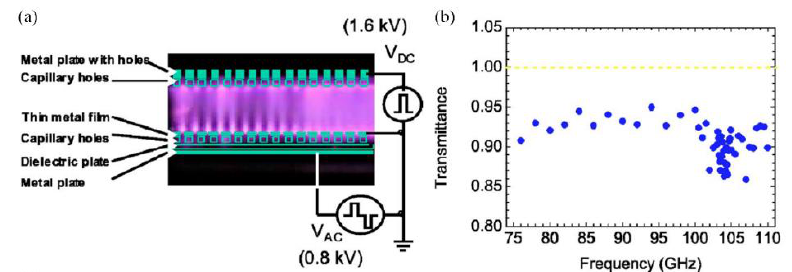
Figure 7. Microplasma column array and its filtering characteristic diagram. ( a ) Schematic diagram of the electrode structure with a lattice constant of 1.5 mm and the discharge diagram of the microplasma column array; ( b ) variation of millimeter-wave transmission coefficient with electromagnetic wave frequency in TE mode [56].